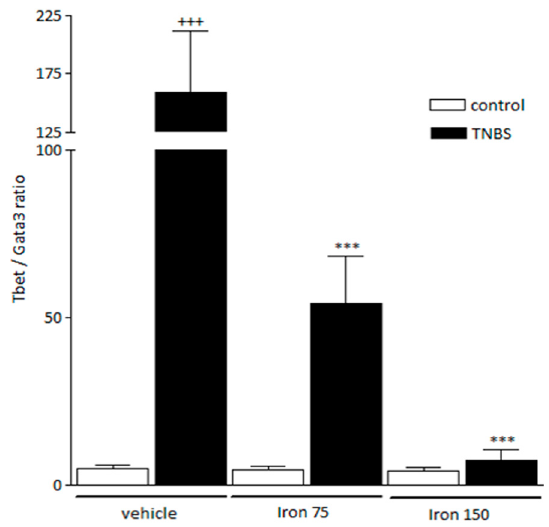
Figure 3. The impact of iron supplementation on the Gata3 and Tbet gene expression ratio in the spleen. Data are expressed as Mean ± SEM. *** Significantly different ( p < 0.001) from vehicle-treated TNBS mice. +++ Significantly different ( p < 0.001) from vehicle-treated control mice. White column: Control mice, Black column: TNBS-treated mice. TNBS instillation resulted in an increase of the Tbet/Gata3 ratio. By contrast, ferric iron ingestion dose-dependently limited the Tbet/Gata3 ratio increase in TNBS-treated mice.